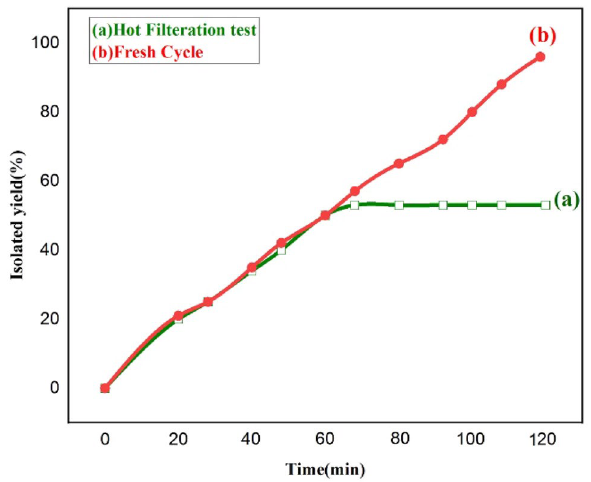
Figure 13. Time-dependent correlation of the product yield in hot filtration test.